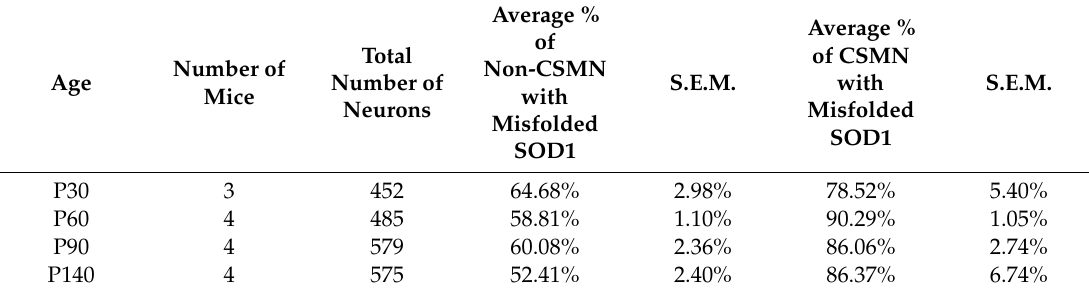
Table 1. Quantification of neurons containing misfolded SOD1 in primary motor